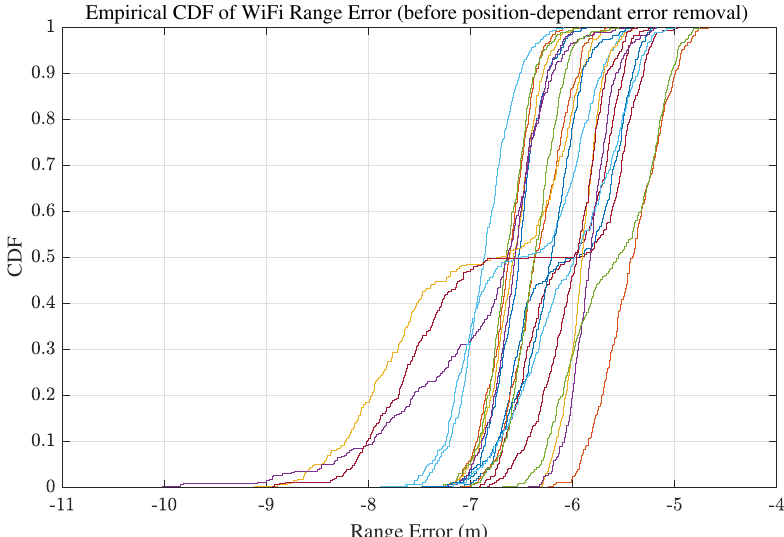
Figure 4. Cummulative Distribution Function (CDF) of range measurement mean error at 21 points in the anechoic chamber.